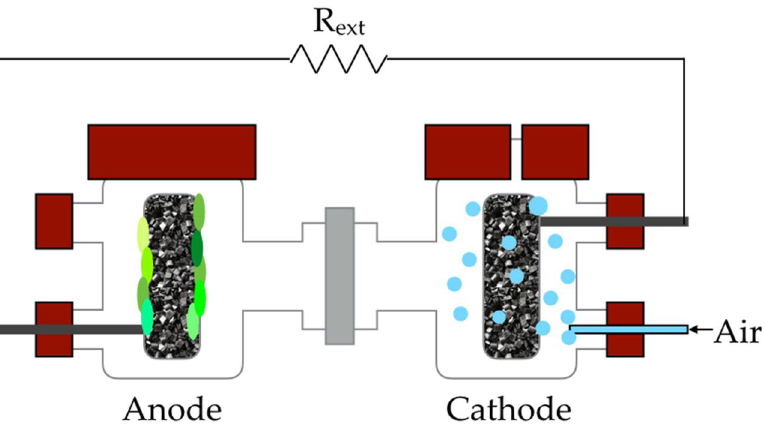
Figure 1. Scheme of the microbial fuel cell used in the experimentation. Air was supplied to the cathode using an air pump. R ext : external resistance.